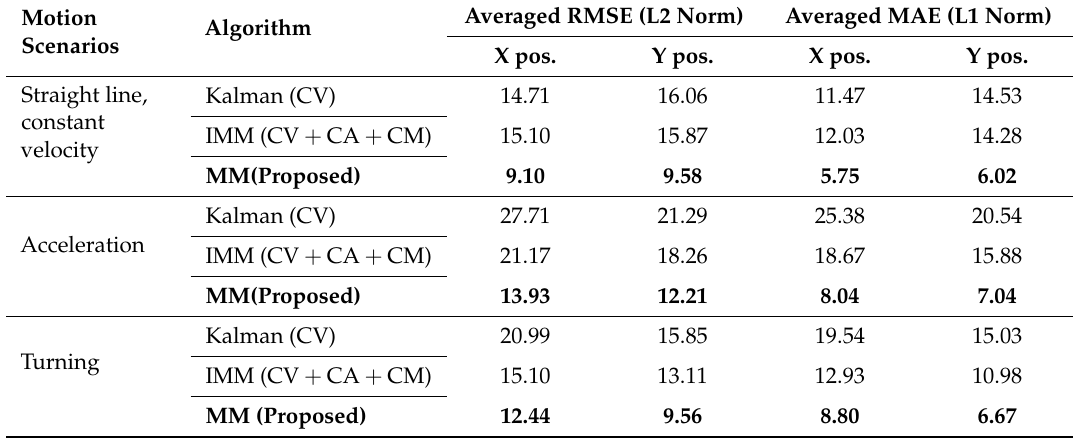
Table 3. Results of averaged RMSE and mean absolute deviation (MAE). SMD (onshore) and the PETS 2016 dataset were split into three di ff erent motion scenarios for the experiment, and a Kalman filter with a single constant velocity (CV) model was used as the benchmark.